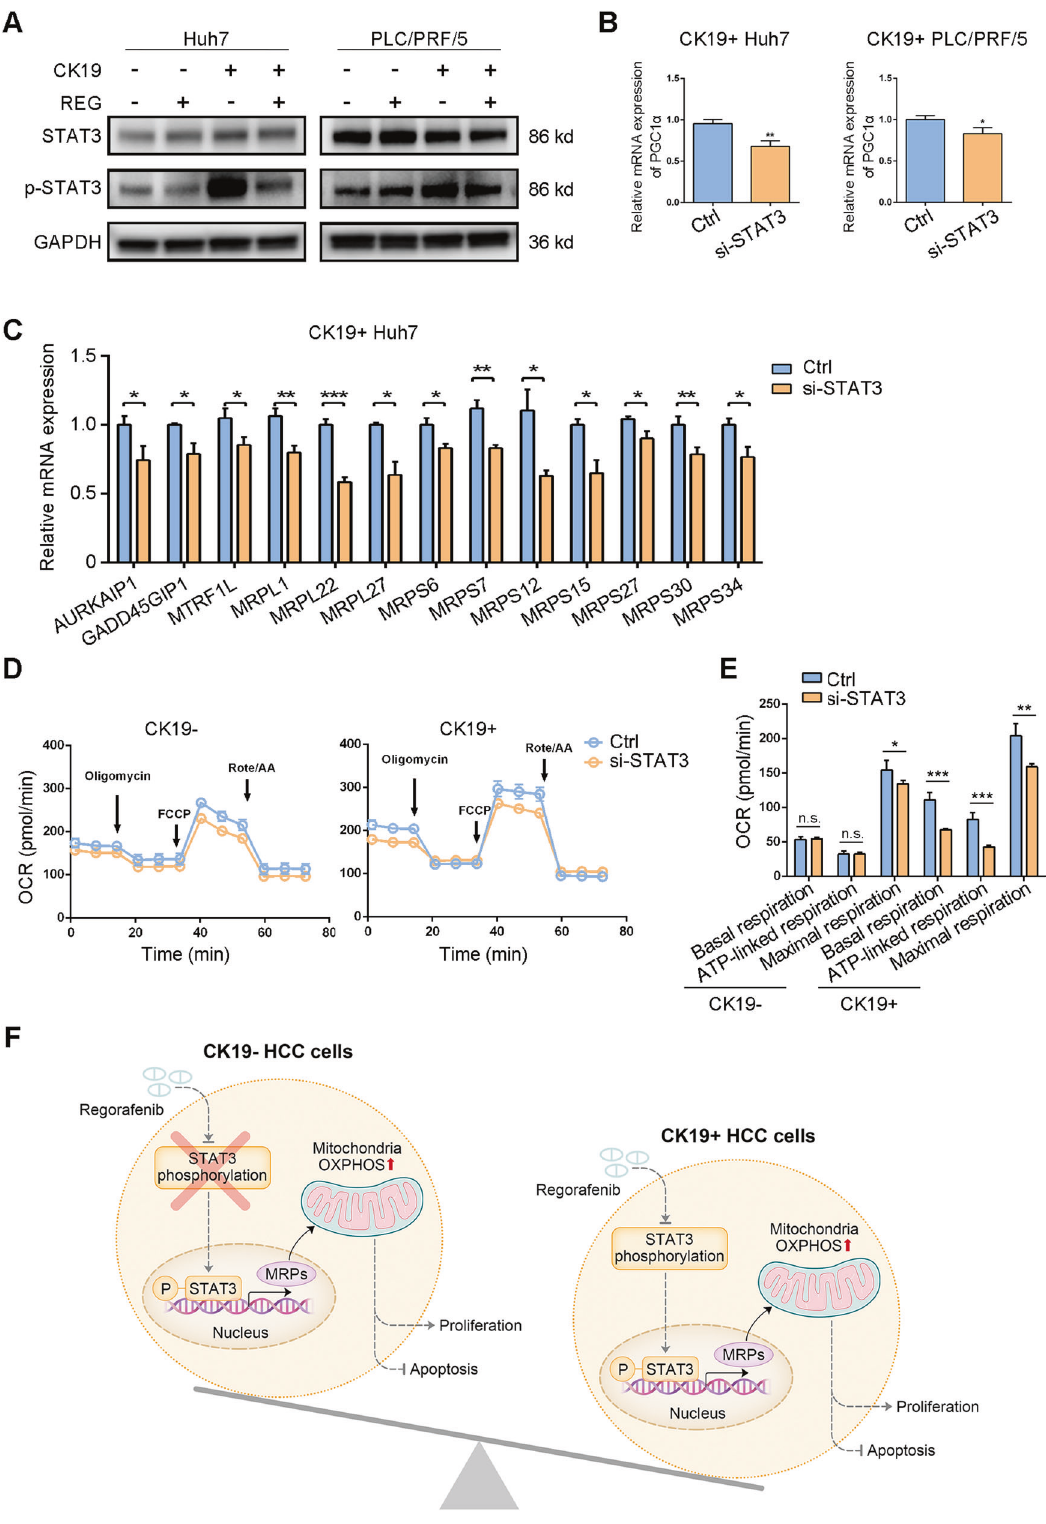
Fig. 7 Phosphorylated STAT3 mediate the mitochondrial function. A Immunoblot analysis of protein extracts from CK19 − and CK19 + cells treated with or without REG, GAPDH was used as a loading control. B The mRNA expression of PGC-1 α after STAT3 knockdown in CK19 + Huh7 and PLC/PRF/5 cells. C The mRNA expression of mitochondrial ribosomal proteins changed after knockdown of STAT3 in CK19 + Huh7 cells. D OCRs of CK19 − cells and CK19 + cells transfected with ctrl and si-STAT3 were measured and normalized to the number of Huh7 cells. E The quantitation of key OCR parameters in CK19 − and CK19 + Huh7 cells transfected with ctrl and si-STAT3. F A theoretic model indicated the distinct effect of regorafenib on CK19 + hepatocellular carcinoma via STAT3-dependent modulation of mitochondrial function. Data are presented as mean ±SD, n.s., not signi fi cant, * P <0.05, ** P <0.01, and *** P <0.001. Ctrl, control; REG, regorafenib; CK19 − , CK19-negative; CK19 + , CK19-positive; STAT3, signal transducer and activator of transcription 3; MRPs, mitochondrial ribosomal proteins; OXPHOS, oxidative phosphorylation. Cell Death and Disease (2021)